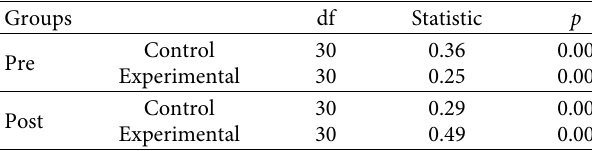
Table 2: Kolmogorov–Smirnov test of normality.